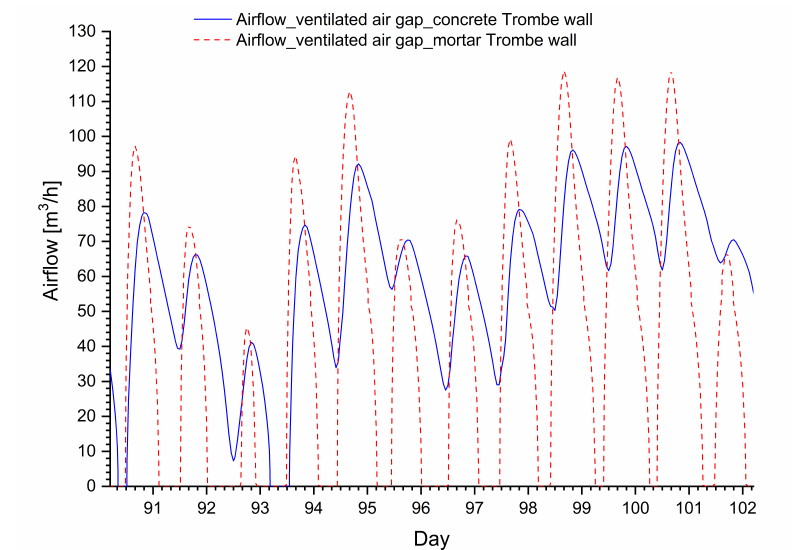
Figure 10. Fluctuations of the airflow rate in the ventilated air gap of the solar Trombe wall fitted with the concrete storage wall (blue) and the mortar storage wall (red).